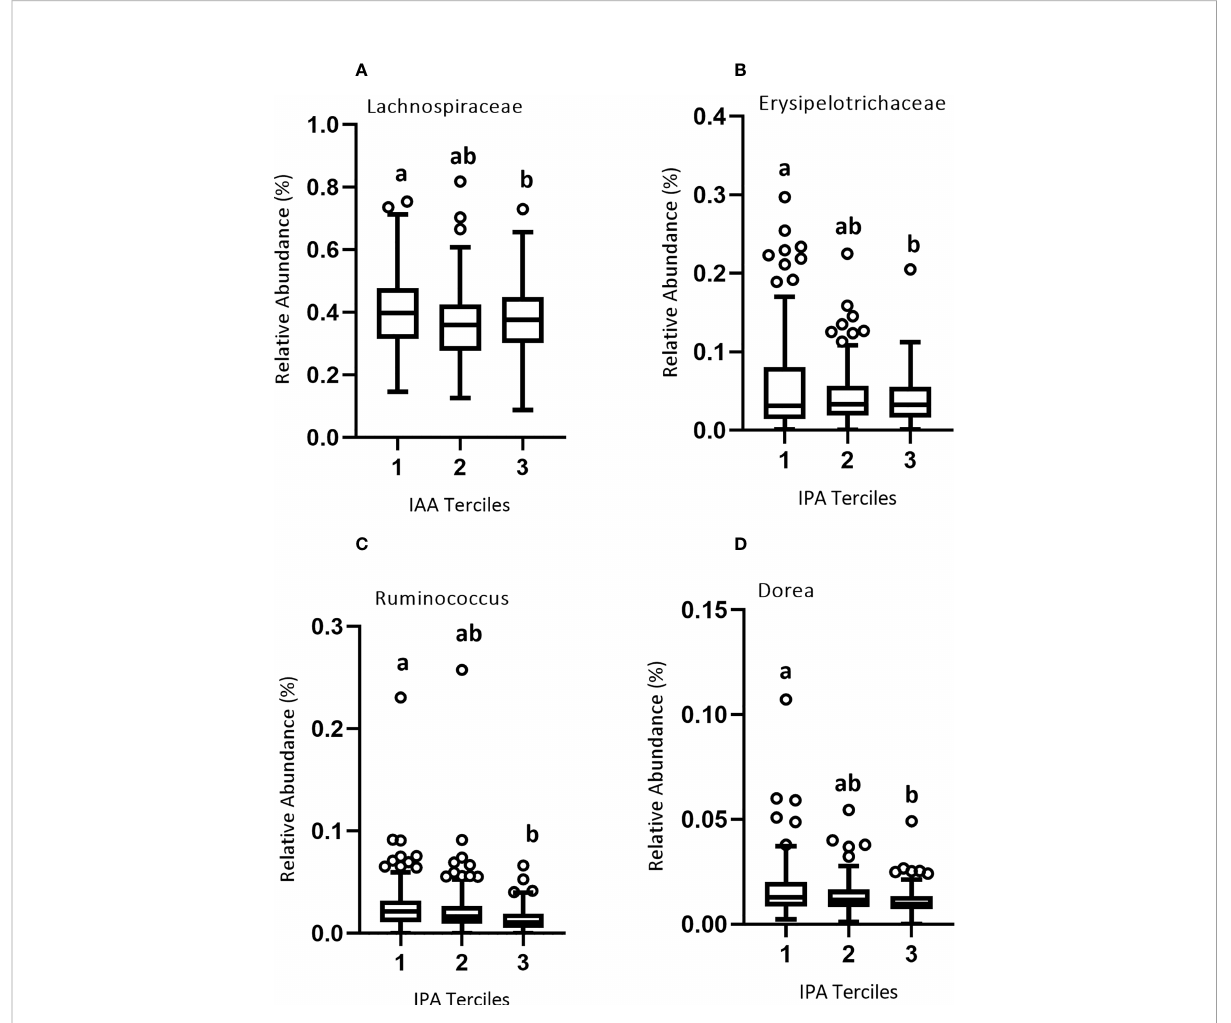
FIGURE 5 Relative abundance of microbial taxa across the three terciles of Trp metabolites. Variability of the percent relative abundance of microbial taxa across the three groups of Trp metabolites is presented using a Tukey's boxplot. The boxplot elements are de fi ned as following: center line, median; box limits, upper and lower quartiles; whiskers, 1.5×interquartile range. Circles indicate outliers. As described in Results, there was a signi fi cant negative association between (A) IAA and family Lachnospiraceae, and between (B) IPA and family Erysipelotrichaceae and (C) IPA and genera Ruminococcus and (D) Dorea. Signi fi cant differences between the groups of Trp metabolites are marked by different